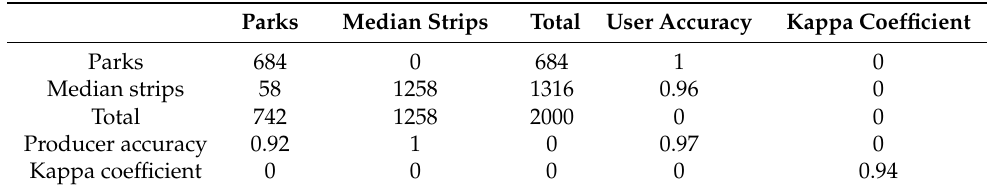
Table 4. Confusion matrix and kappa